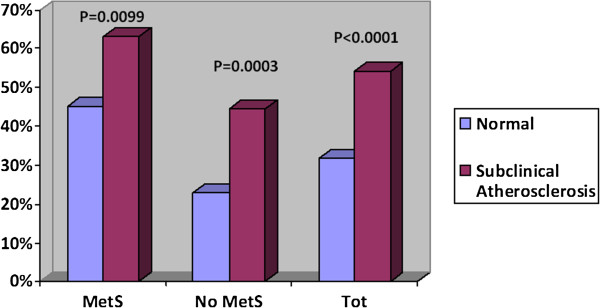
Comparison of incidence of events in the subgroups of study.